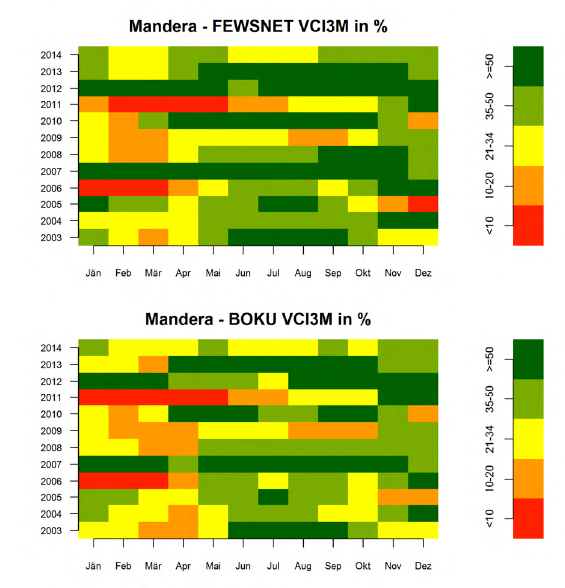
Figure 9: Seasonal matrix plot of categorised monthly VCI3M anomalies for the county of Mandera (2003-2014) derived from (top) FEWS NET dataset and (bottom) BOKU